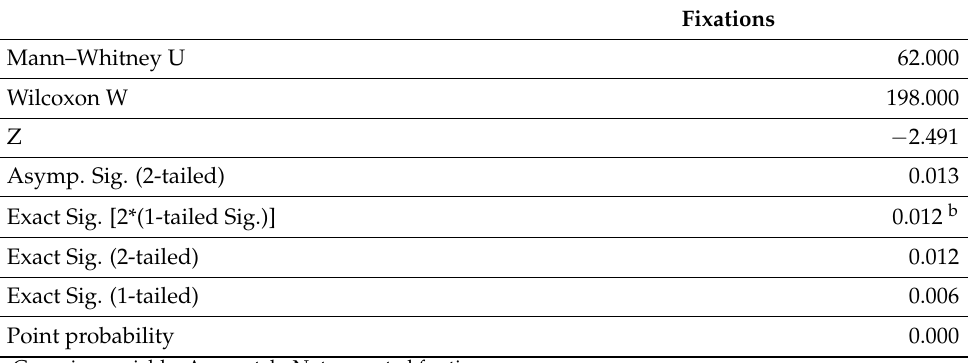
Table 9. Test Statistics a